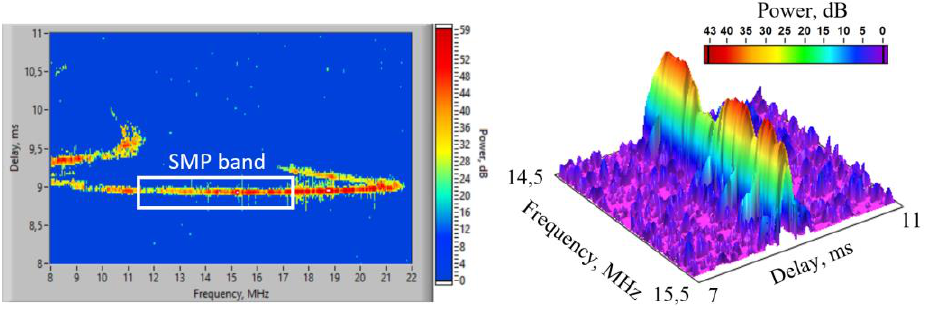
Fig. 1. Ionogram (left) of panoramic oblique sounding over the Cyprus-to-Yoshkar-Ola radio path by the LFMCW signal and AFR (right) of the wideband (1 MHz) channel from the single mode propagation